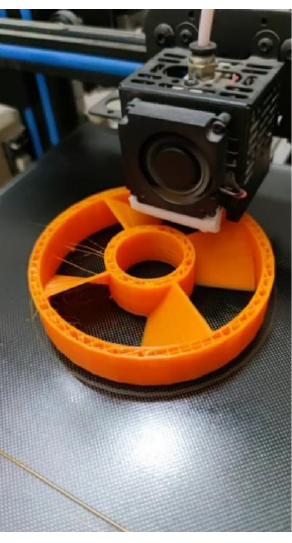
Figure 2. 3D-printed laboratory model.